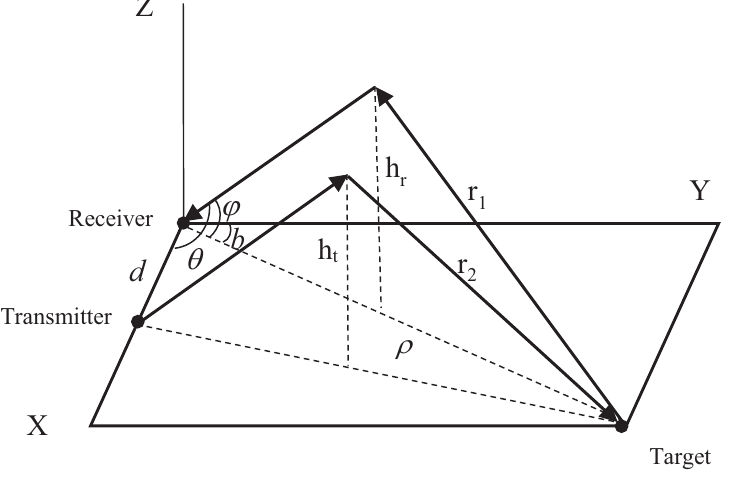
Figure 1. Geometry of the planar OTHR system.